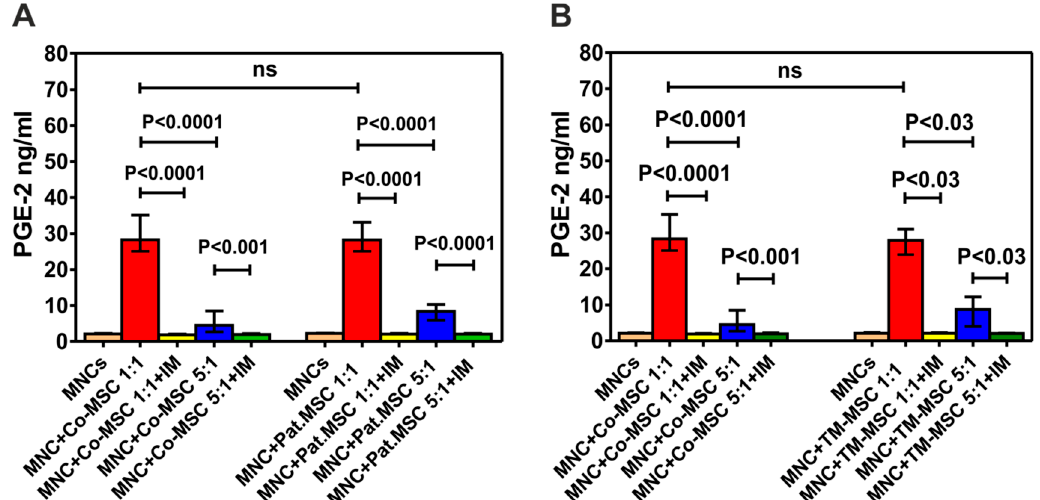
Figure 5. Concentration of PGE2 in the supernatants of MLR with MSCs from patients with NMHD and healthy donors. ( A ) Comparison of the PGE2 values in patients’ group with the control group ( B ) Comparison of the PGE2 values in patients with thalassemia and control group. Co: Control, Pat. MSC: Patients’ MSCs, IM: Indomethacin, TM: Thalassemia Major.